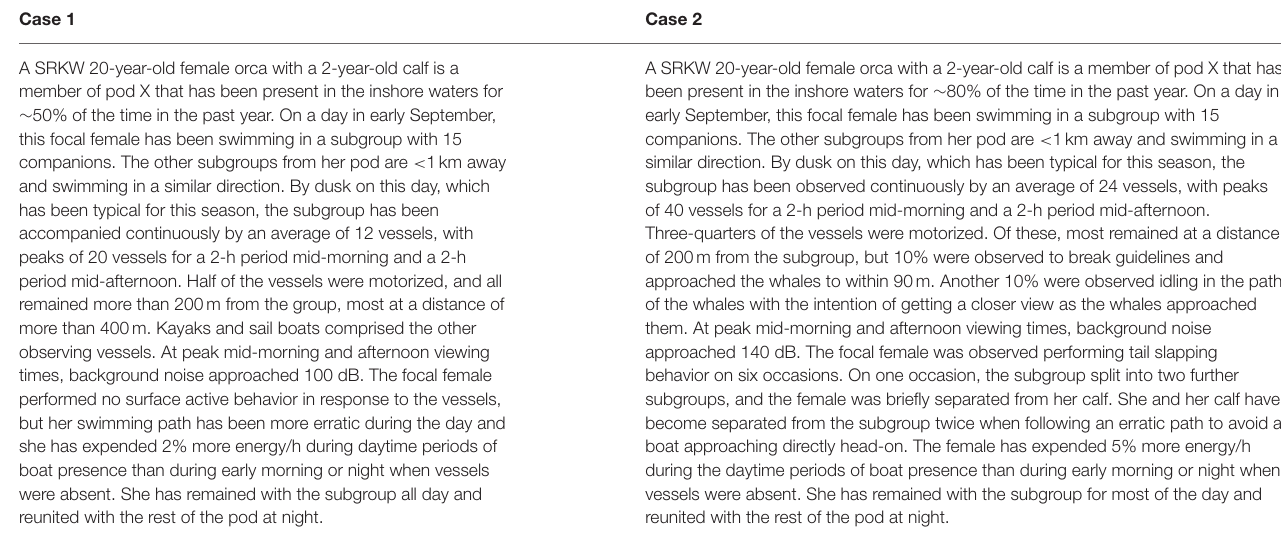
TABLE 1 | Two cases concerning different levels of exposure to vessel traffic for individuals belonging to a hypothetical Southern Resident killer whale (SRKW) pod. Case 1 Case